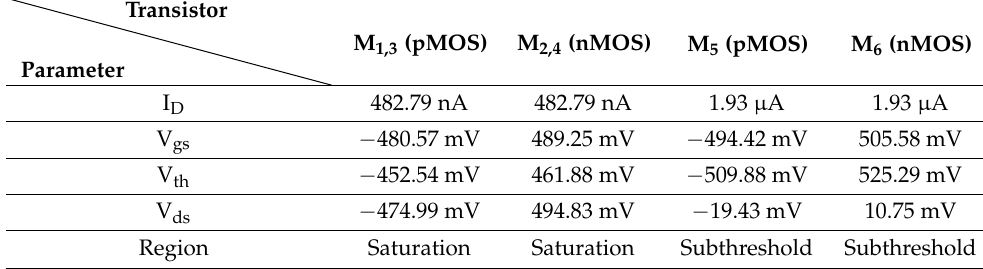
Table 4. The transistors’ voltage, current, and region in the proposed inverter-based amplifier.